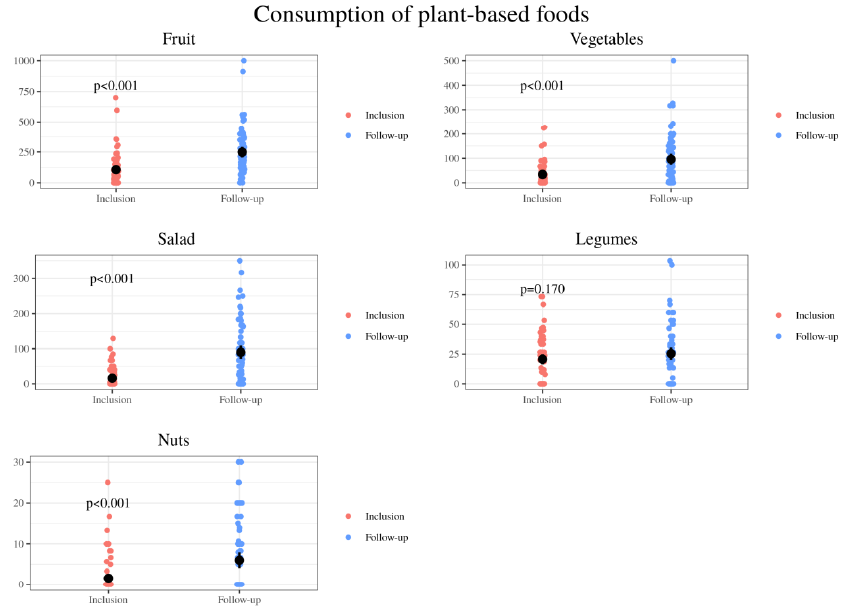
Figure 6. Comparison of the relative consumption of plant-based foods: grams of fruit, vegetables, salad, legumes and nuts per day consumed by 72 CD pediatric individuals at baseline (inclusion) and after nutrition education (follow-up).